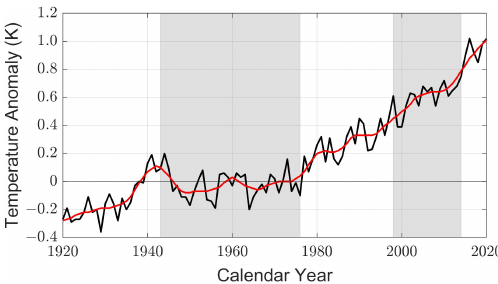
Figure 1. Anomaly in global mean surface temperature (GMST) between 1920–2020 with respect to the average value between 1951–1980, —— : annual mean value [31], —— : annual mean value smoothed with LOWESS (locally weighted scatterplot smoothing) over five-year window [31], grey region: hiatus periods in 1943–1976 and 1998–2014.